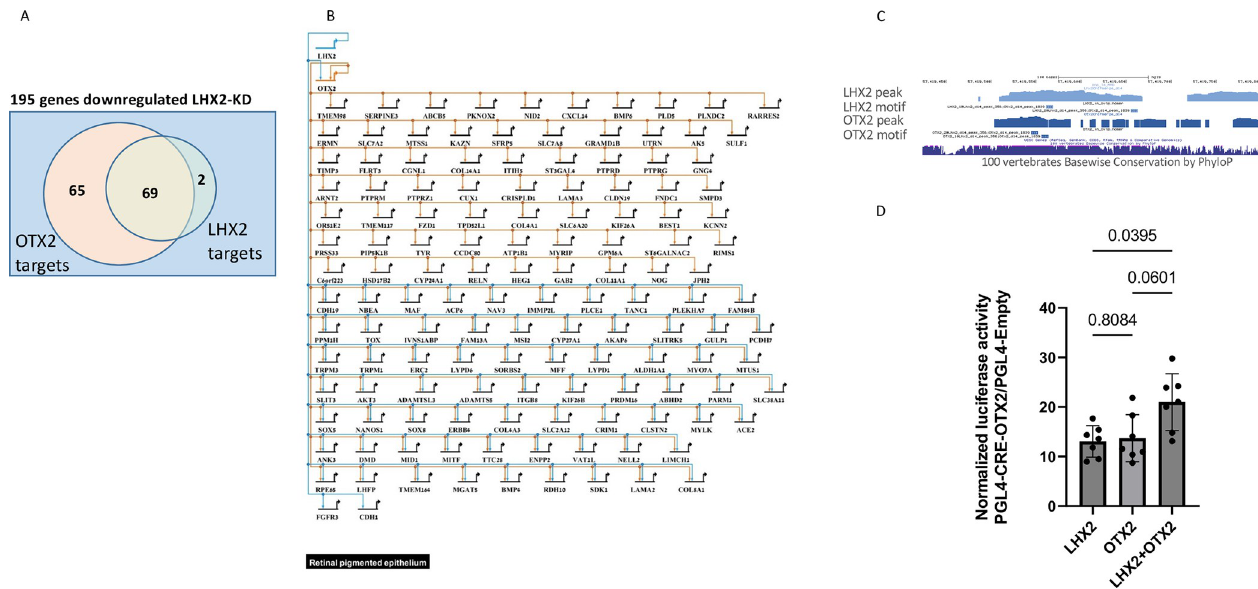
Fig 4. LHX2–OTX2 gene-regulatory network and functional validation on CRE–OTX2 by reporter assay. (A) Overlap between OTX2 and LHX2 predicted gene targets based on proximity to the bound regulatory regions and gene down-regulation following LHX2 KD. (B) Model of the LHX2 and OTX2 gene- regulatory networks in hES-RPE cells (generated using BioTapestry; http://www.biotapestry.org/). (C) Overview of a conserved genomic region associated with LHX2 and OTX2 (CRE–OTX2) within the previously identified hs1150 enhancer. The ChIP-seq peaks and motifs of LHX2 and OTX2 are indicated. (D) The PGL4-CRE–OTX2 reporter activity normalized to control PGL4.23-Empty is induced by the co-expression of LHX2 and OTX2 more than the relative elevation by each TF alone. The p -values were calculated by one-way ANOVA, matched, and corrected with Tukey’s test for multiple comparisons ( N = 7, the data and analyses are detailed in S10 Table). CRE, cis -regulatory element; KD, knockdown.